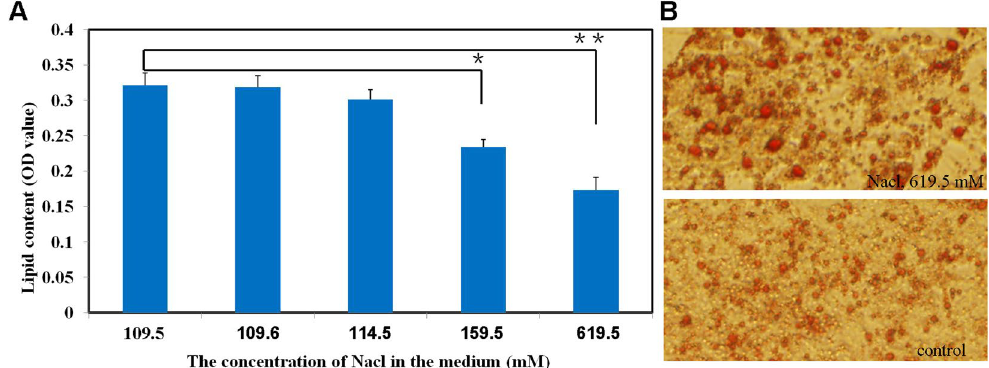
Figure 3. The effect of NaCl on lipid content in 3T3-L1 cells. Cells were examined, 10 d after inducing differentiation, in media containing 0, 0.0005 M, 0.005 M, 0.05 M, or 0.5 M additional NaCl. ( A ) The lipid content significantly decreased with 0.05 M and 0.5 M additional NaCl compared with controls. Data are means ± SEM, n = 6. * P < 0.05; ** P < 0.01. ( B ) Morphological changes and lipid deposition induced by 0.5 M additional NaCl (200 ×